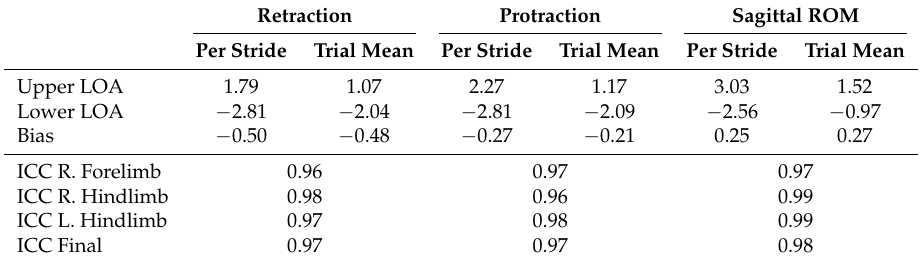
Table 5. Summary of measurement agreement statistics for the sagittal limb angles at trot (values in degrees).